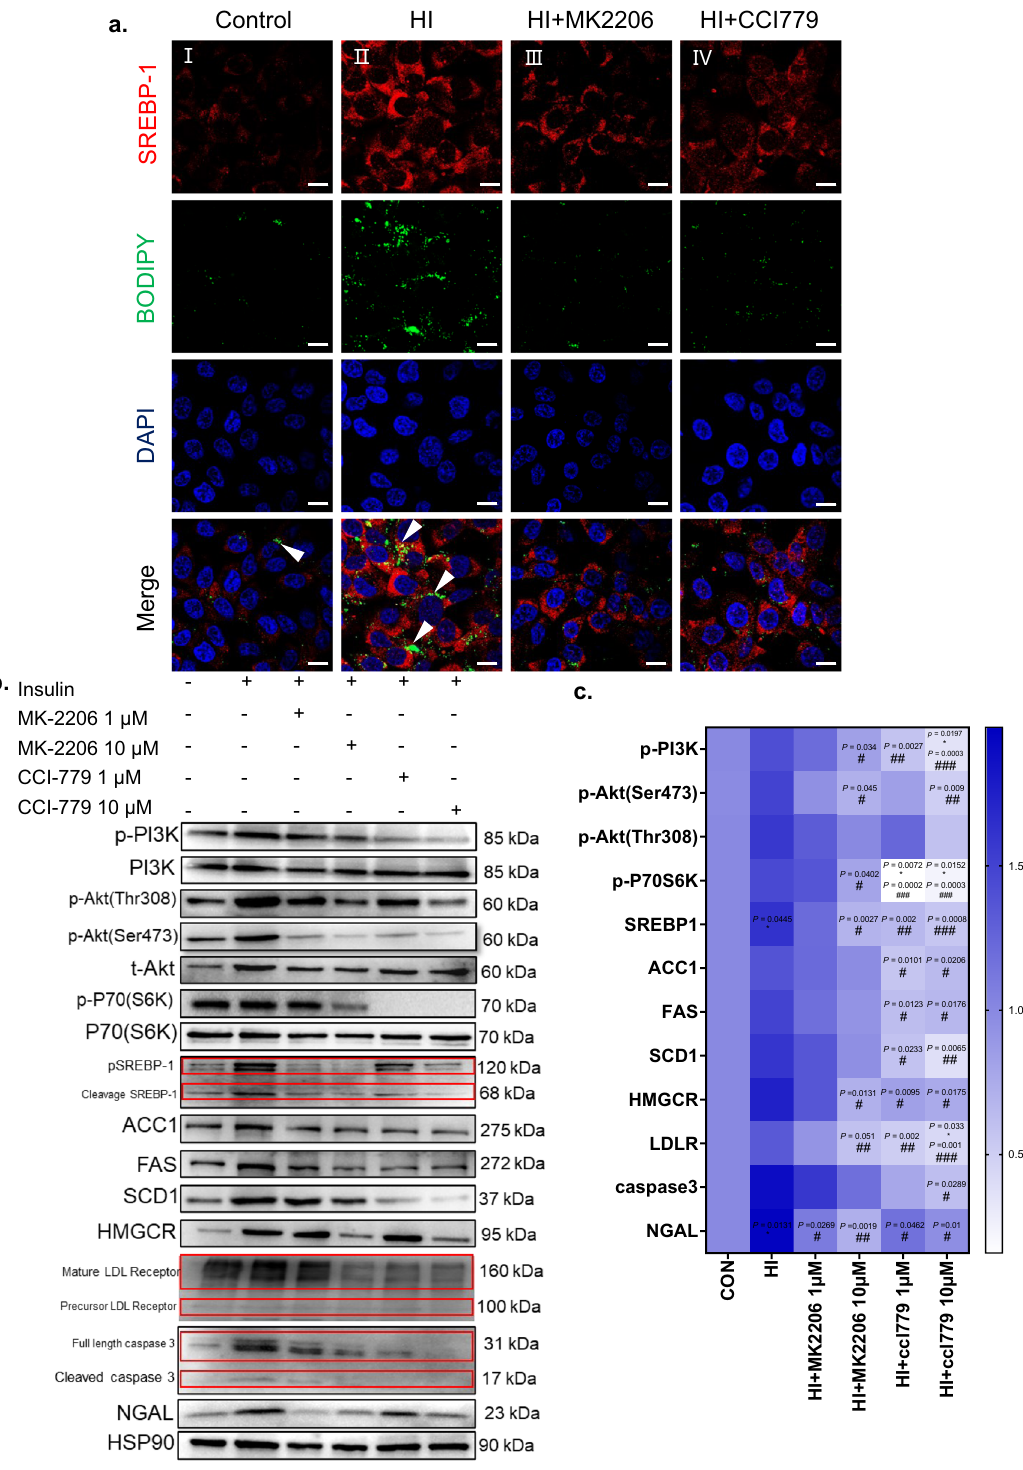
Fig. 8 | Activating SREBP-1 inHK-2cells aggravatedlipiddeposition.a SREBP-1 (red) and BODIPY (green) expression was evaluated by immuno fl uorescence on HK-2 cells treated with negative control (Con) or insulin incubated with OA (120 μ M) (Hight insulin, HI), or HI incubated with 10 μ M Akt inhibitor MK2206 (HI+MK2206),10 μ MmTORinhibitorCCI779(HI+CCI779).FITC-labeledBODIPY, Alexa Fluor 594-labeled SREBP-1 and DAPI (nuclei, blue) were used. SREBP-1 is mainly expressed in the cytoplasmic of HK-2 cells, BODIPY in the cytoplasmic of HK-2 cells, and the speci fi c location is indicated by the arrows. Representative image from three biologically independent samples/group were combined from three independent experiments. Original magni fi cation ×630. Scale bar: 10 μ m.